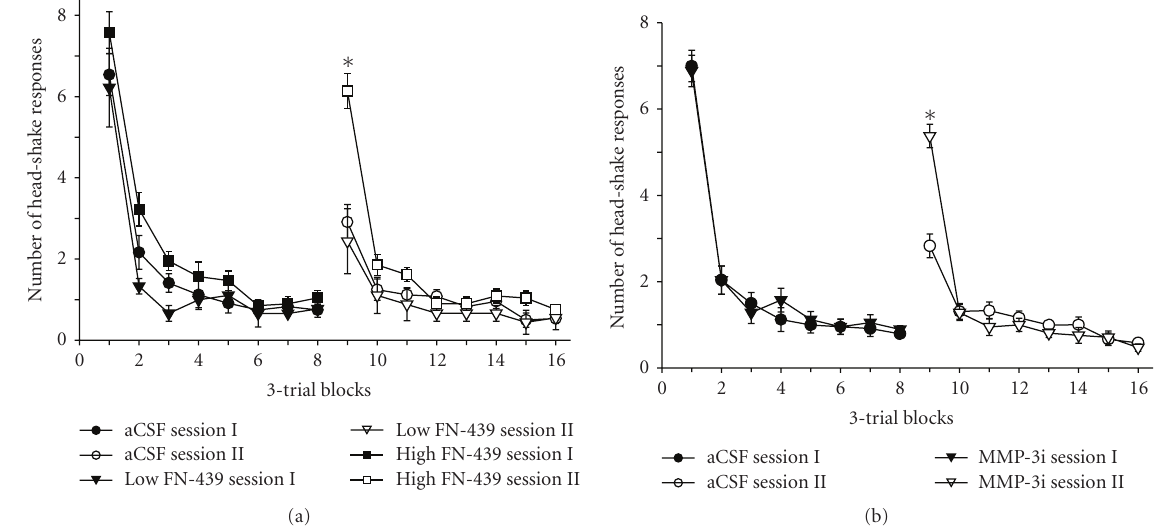
Figure 3: Mean ( ± SEM) group changes in number of HSR per 3-trial blocks during sessions I and II of habituation trials separated by a 24 hours ISI. (a) These independent groups of rats were bilaterally infused into the dorsal hippocampus with artificial cerebrospinal fluid (aCSF, 2.5 μ L each side), a low dose of FN-439 of 25 μ g (Low FN-439), or a high dose of FN-439 of 50 μ g (High FN-439) at 5 and 60 minutes following the termination of session I. All groups received a contingent signaling tone immediately prior to the air stimulus on each trial. There were no di ff erences among the groups concerning the pattern of habituation during session I. There were di ff erences among the groups during the first trial block of session II with the high FN-439 group revealing a significantly higher level of spontaneous recovery (poorer memory retention) as compared with the other two groups that did not di ff er. (b) Members of these two groups were bilaterally infused with aCSF or MMP-3 inhibitor (MMP-3i, 50 μ g in 2.5 μ L aCSF) into the dorsal hippocampus at 5 and 60 minutes following the conclusion of session I. Members of both groups received contingent tone immediately pior to the application of the air stimulus on each trial. The two groups did not di ff er regarding pattern of habituation during session I; however, members of the MMP-3 inhibitor group revealed a significantly higher level of spontaneous recovery (poorer memory retention) as compared with the aCSF group during the first trial block of session II, ∗ P < . 0001, modified from Wiediger and Wright